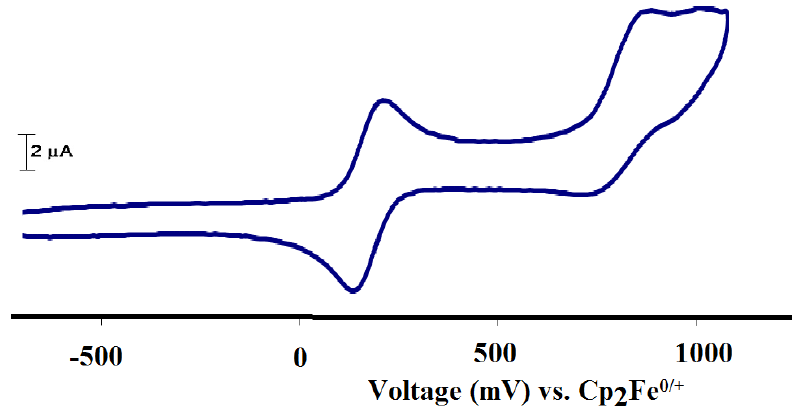
Figure 8. Cyclic voltammograms of complex 1 Data reported in mV vs . Cp electrode with A = 0.0064 cm 2 , tetra- n -butylammonium hexafluorophosphate TBAHF,